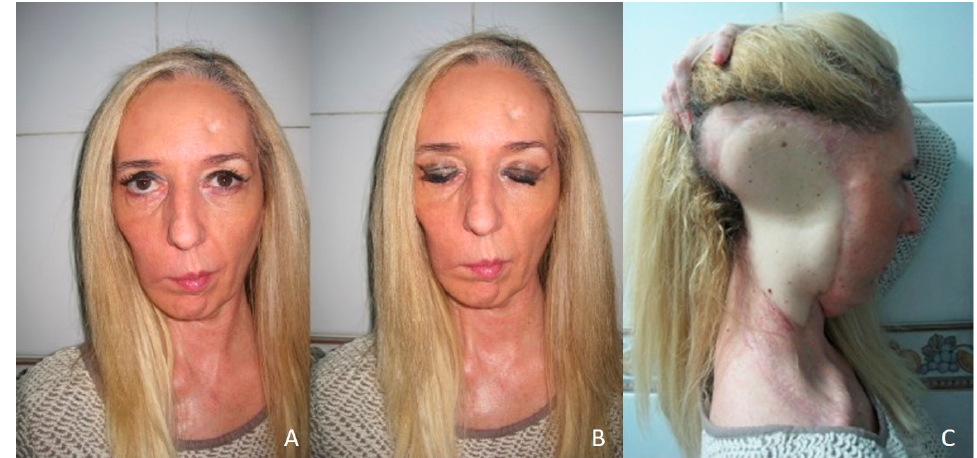
Figure 6. LD flap. ( A , B ) Aesthetic and functional result one year after surgery. ( C ) Poor aesthetic result one year after surgery. Significant difference in color and texture from the surrounding tissue.